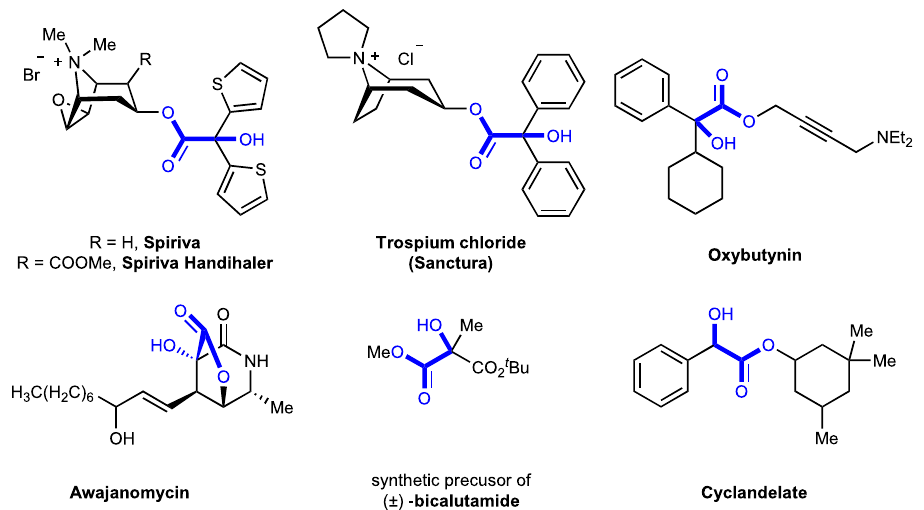
Fig. 2 The signi fi cance of α -Hydroxycarboxylic acids. Selected examples of bioactive molecules and natural products that containing α -Hydroxycarboxylic acids moiety.